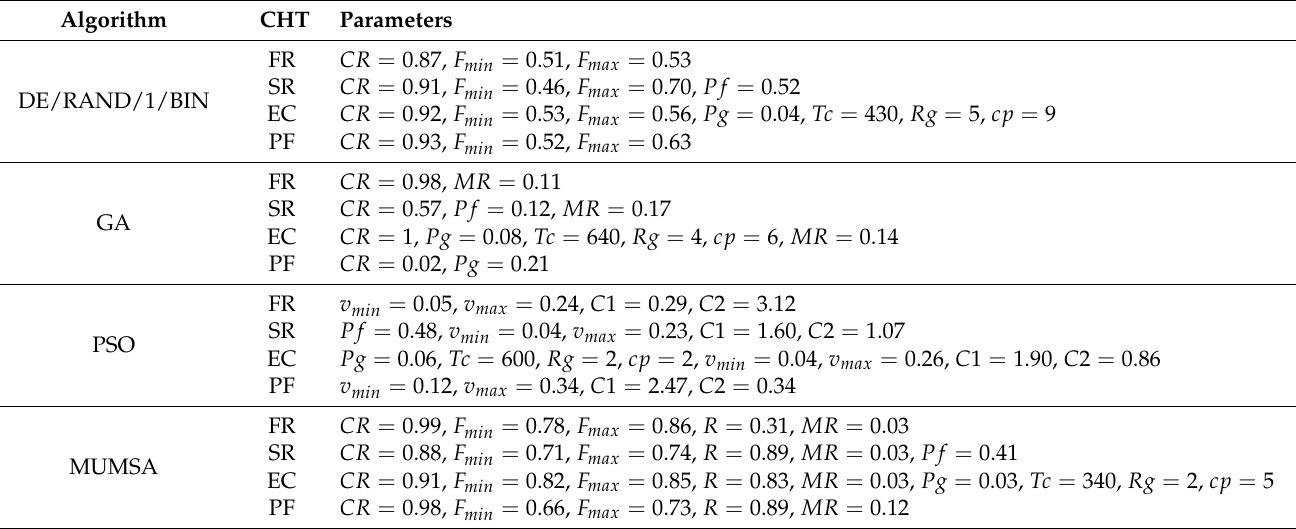
Table 3. Algorithm parameter setting obtained by the irace package in study case 2.